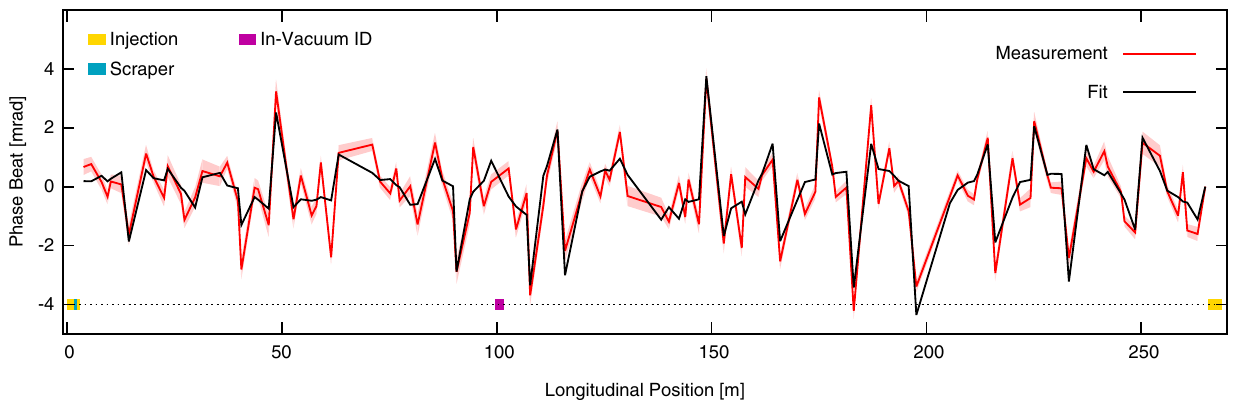
FIG. 9. Measured phase beat for each BPM along with the one computed from the high β v model including the three measured defocusing kicks produced by the beam pipe, the injection section and the IVU located at the high vertical beta